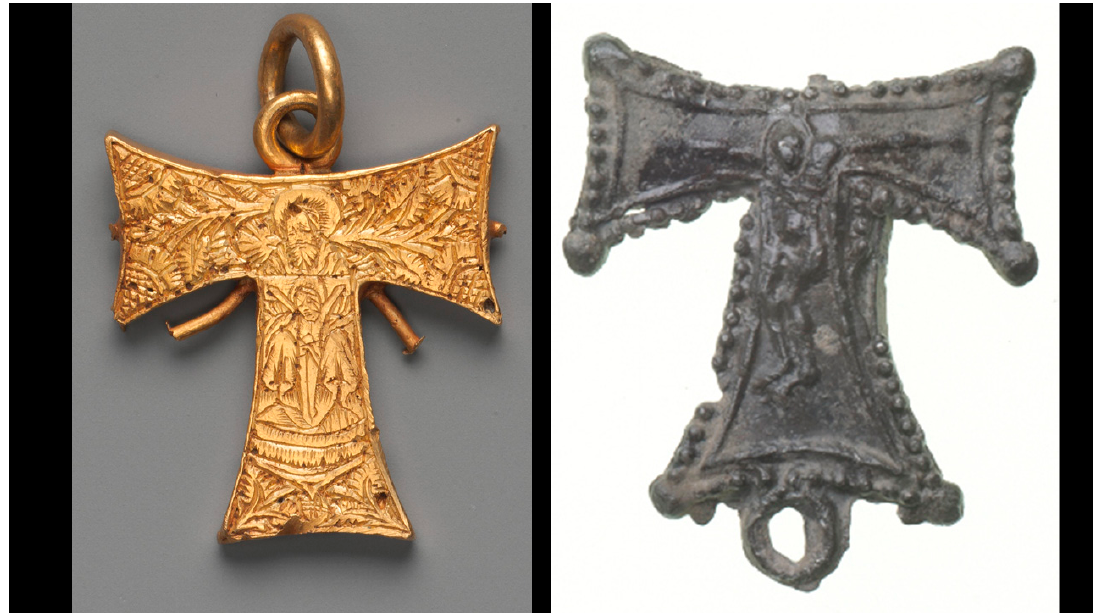
Figure 3. ( Left ) Pendant Tau Cross with Trinity and Virgin and Child, gold, England, c. 1485, New York: The Cloisters Collection. Photo: Cloisters Collection. ( Right ) Pilgrim badge tau cross with crucified Christ, pewter, England, 15th century. Museum of London. Photo: Museum of London.